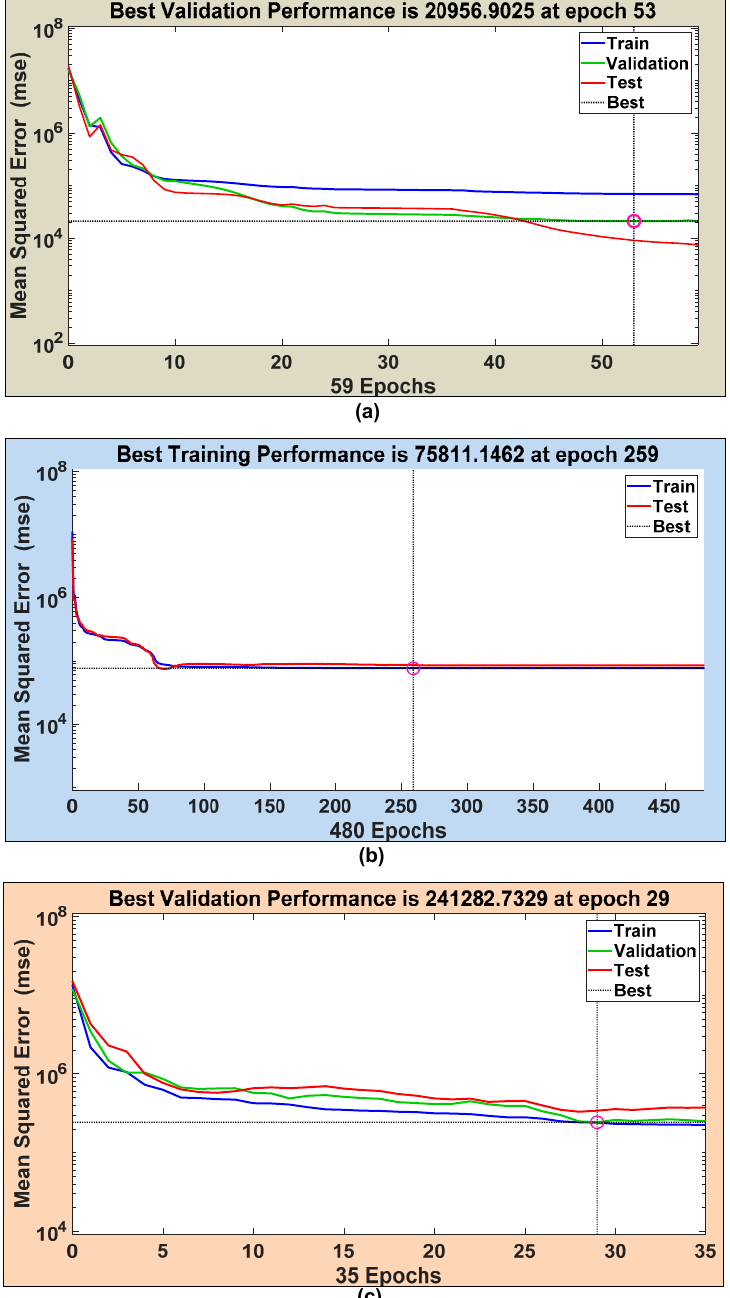
Figure 12. Performance plots of ANN with ( a ) Levenberg–Marquardt (LM) algorithm, ( b ) Bayesian Regulation (BR) algorithm, and ( c ) Scaled Conjugate Gradient (SCG) algorithm.